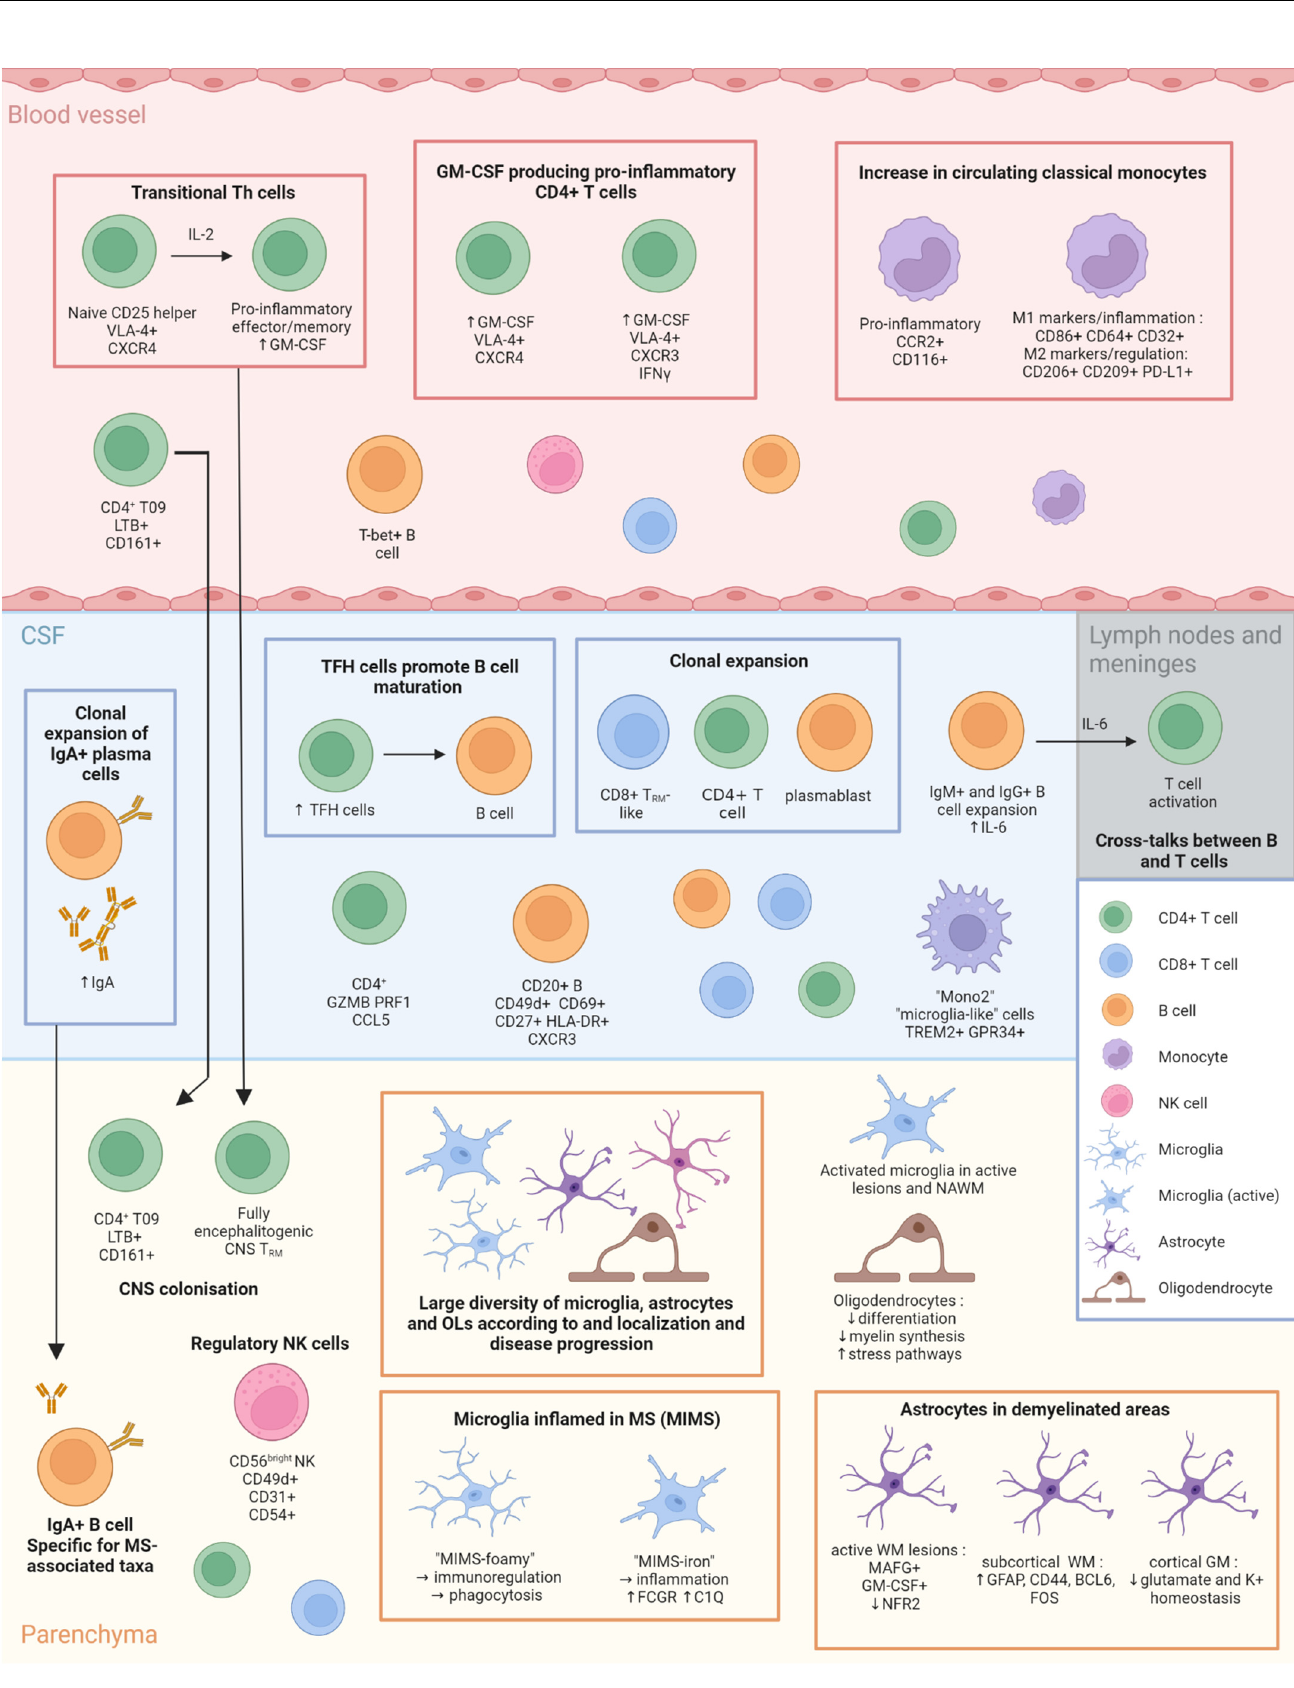
Figure 1. Representation of relevant cell types found in the blood, CSF and CNS during MS inflammation. Cells represent highlights discussed in this review. Figure made by authors using Biorender.com.